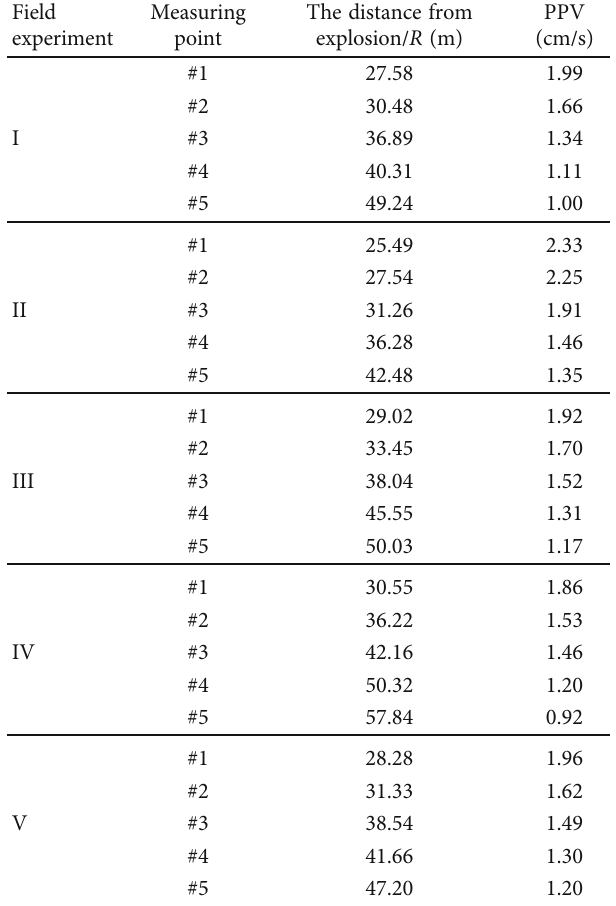
Table 1: Measured peak blasting vibration velocity. Field